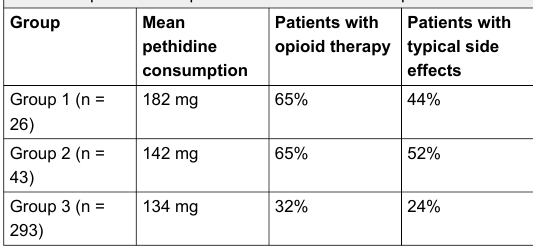
Table 1: Opioid consumption and side effects from